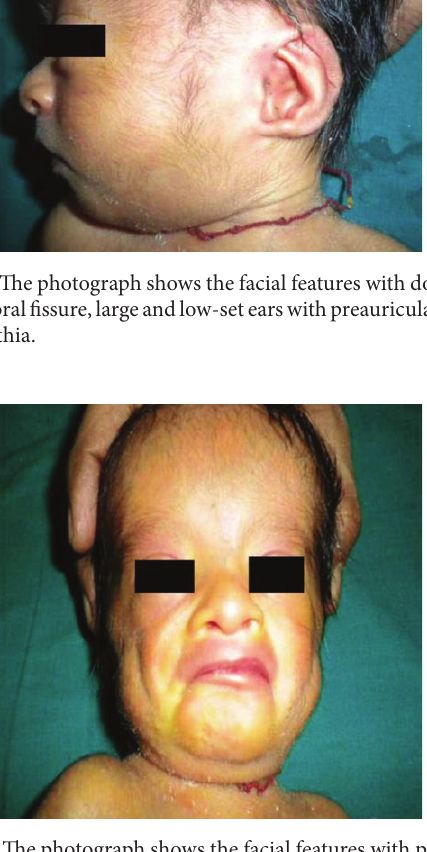
Figure 2: The photograph shows the facial features with prominent forehead, widely separated eyes with downslanting palpebral fissure, and micrognathia.